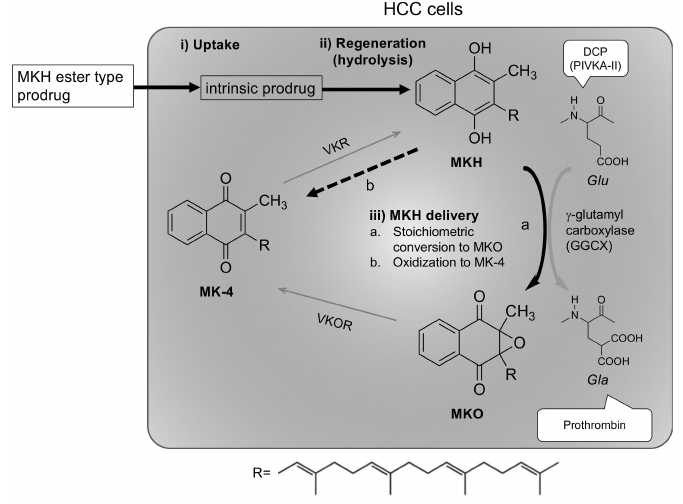
Figure 1. Schematic illustration of the vitamin K cycle and concept of the menahydroquinone-4 (MKH) delivery system. Expected steps of MKH delivery: ( i ) uptake of the MKH ester prodrug; ( ii ) regeneration to parental form MKH; ( iii ) determination of MKH delivery, (a) stoichiometric conversion to menahydroquione-4 epoxide (MKO) and (b) oxidization to menaquinone-4 (MK-4). VKR, vitamin K reductase; VKOR, vitamin K epoxide